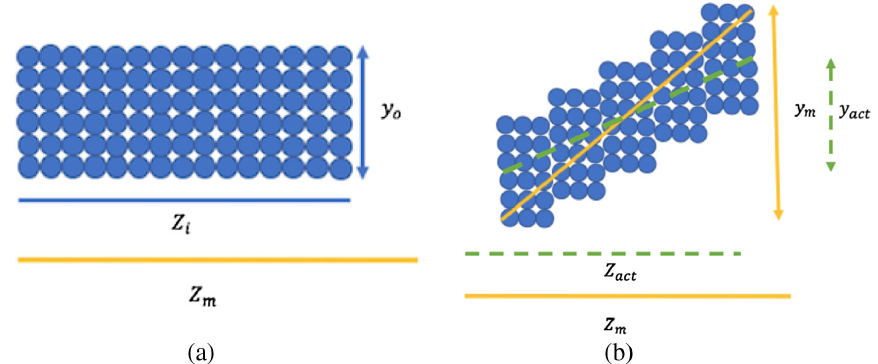
FIG. 5. (a) Initial longitudinal view of idealized bunch from the side. y 0 is the transverse size without deflection, Z i is the initial longitudinal bunch length (b) Longitudinal view of a deflected idealized bunch from the side. y m is the measured transverse projection after deflection, y is the value that would ideally be measured, Z m will be the calculated bunch length from the measurement, Z act ideally calculated length. Visual inspection comparing Z i and Z to Z m demonstrates the concept of how this error overestimates the act true bunch